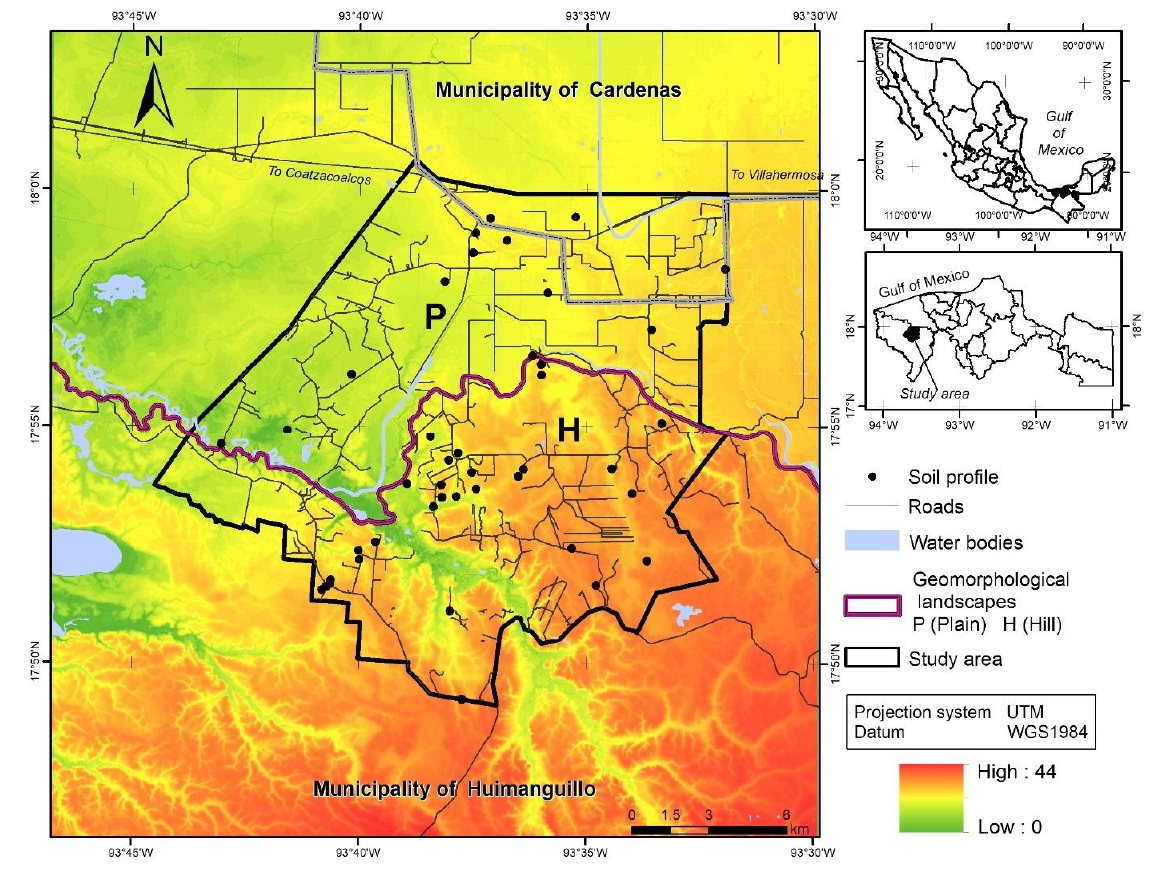
Figure 1. Location of study zone.